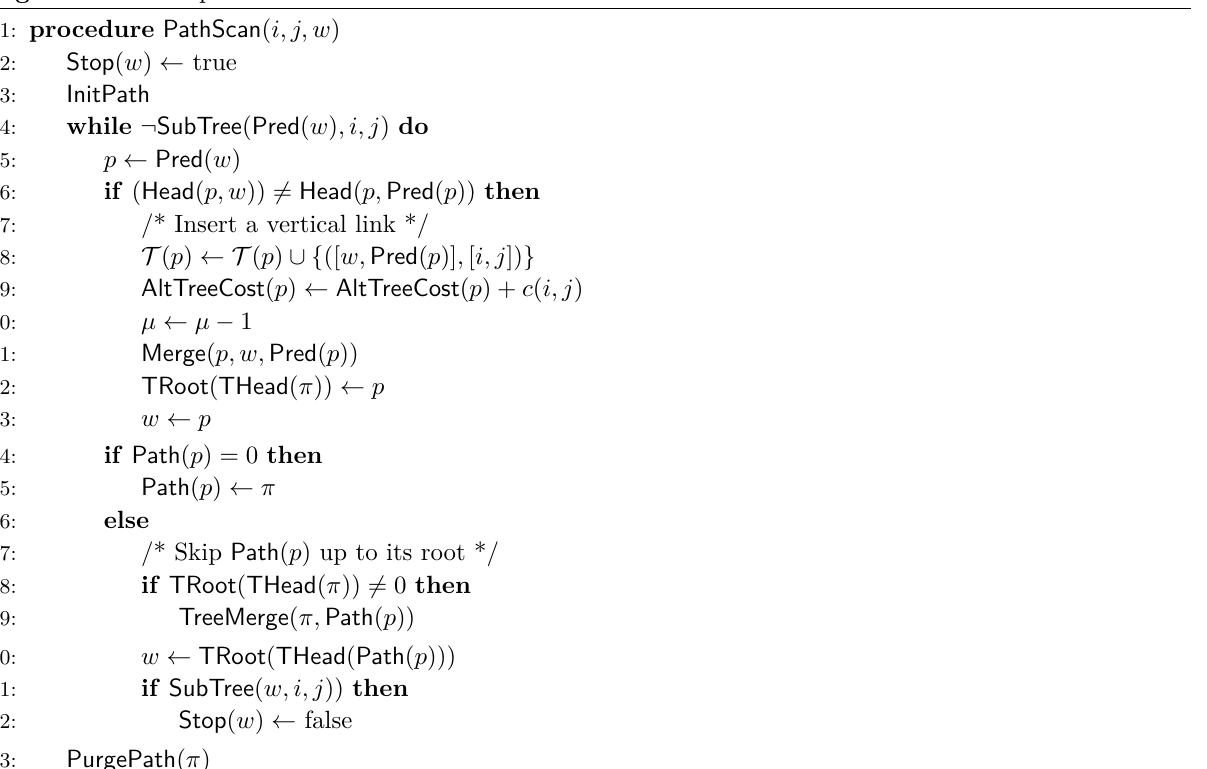
Algorithm 9 The procedure that inserts vertical